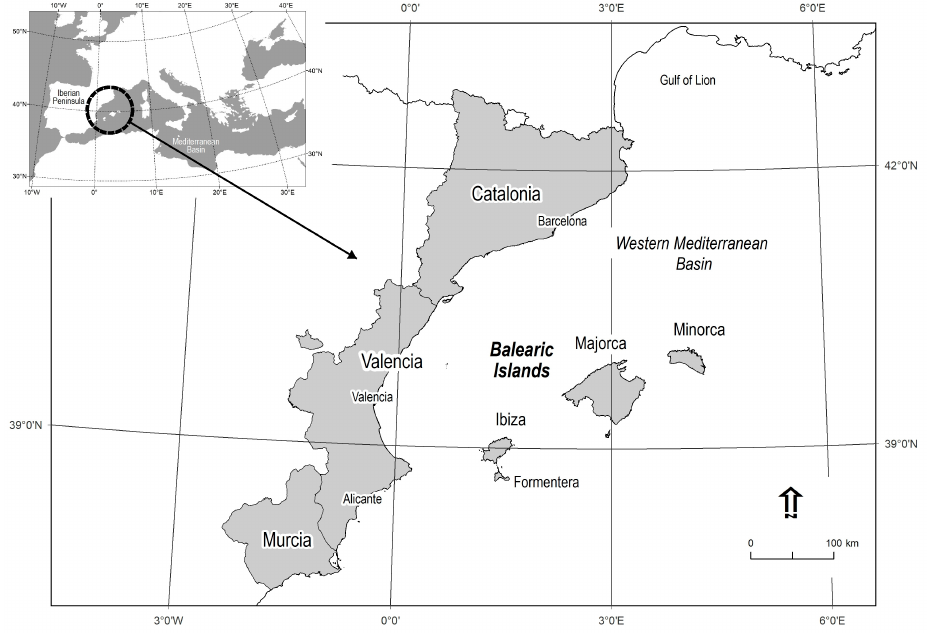
Figure 1. The Balearic Islands in the Western Mediterranean Basin.